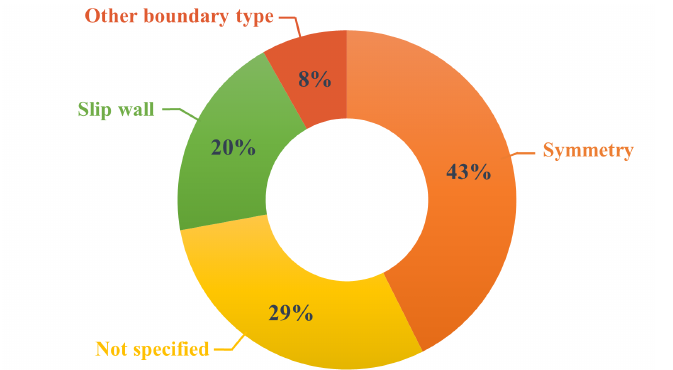
Figure 20. Lateral boundaries